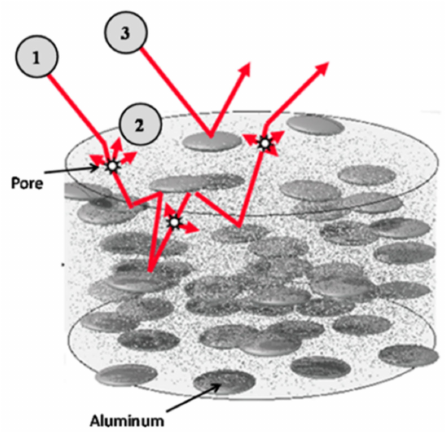
Figure 4. Illustration of scattering mechanisms that occur in cermets in the transparent region. (1) Refraction between air and alumina and multiple reflections on aluminum splats; (2) pore scatter- ing; (3) surface reflections on aluminum splats, reproduced from [27], with permission of ACS